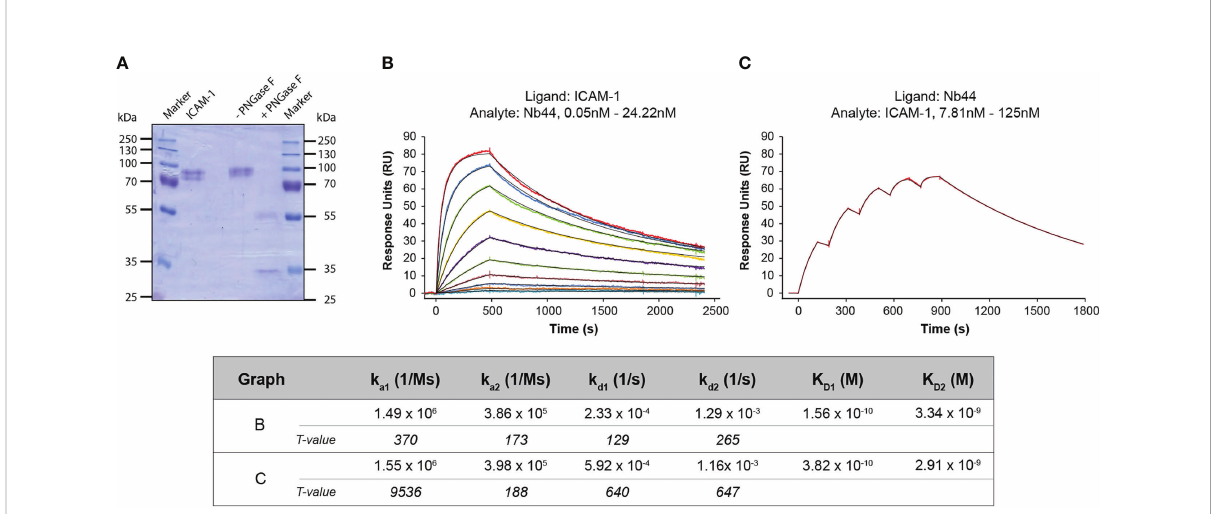
FIGURE 3 SPR-based study of the interaction between Nb44 and ICAM-1. (A) Separated and Coomassie Brilliant Blue-stained reaction mixtures of ICAM-1 deglycosylated by PNGase F. Lane 1: protein molecular mass marker (M), lane 2: ICAM-1, 1 µg, lane 3: ICAM-1 in reaction mixture without (-) PNGase F, lane 4: with ( + ) PNGase F, lane 5: protein molecular mass marker. Molecular masses are displayed on both margins in kDa. (B) Multi- cycle kinetics using ICAM-1 as ligand and Nb44 as analyte. Different colored lines correspond to different concentrations of Nb44. (C) Single- cycle kinetics with Nb44 as ligand (captured by anti-His-tag antibodies) and ICAM-1 as analyte. (B, C) Recorded curves (colored) were superimposed with calculated curves (black) according to a heterogeneous ligand model. Signal intensities (RU, y-axes) are shown versus time (in seconds, x-axes). Association and dissociation rate constants (k a , k d ), dissociation constants (K D ) and T values for each parameter are indicated. Displayed graphs are representatives of 4 (B) or 3 (C) independent experiments.